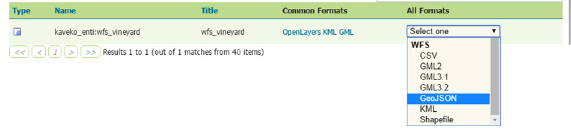
Figure 14. Layers offered through WFS service and the GEOJSON